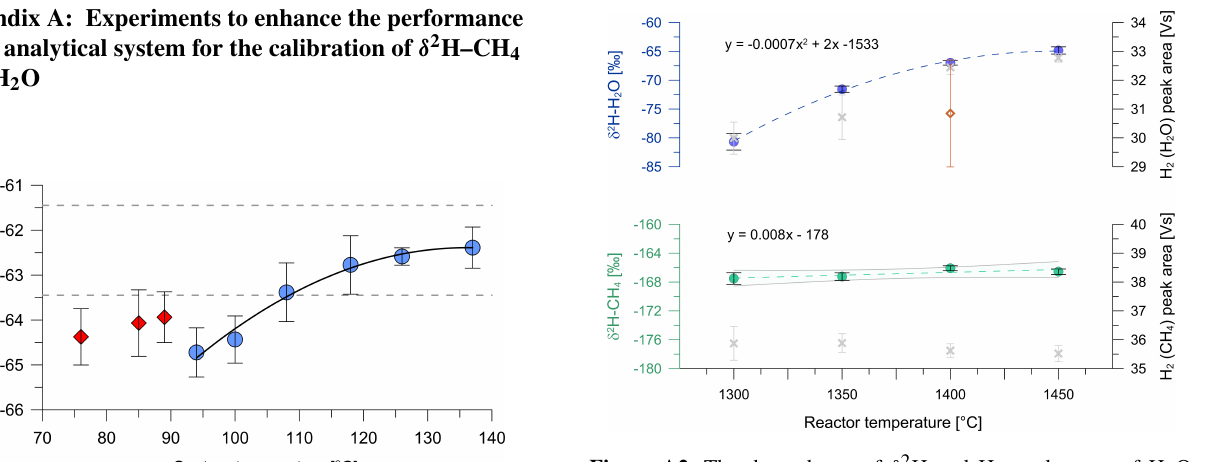
Figure A2. The dependence of δ 2 H and H 2 peak areas of H 2 O and CH 4 injections from reactor temperatures between 1300 and 1450 ◦ C. Top and bottom panels show H 2 O and CH 4 experiments respectively. δ 2 H isotope ratios are shown in blue for H 2 O and green for CH 4 and refer to the left-hand axes. Average H 2 peak areas are indicated by grey crosses and refer to the right-hand axes. All error bars indicate the standard deviation. The red diamond shows the average peak area and the respective standard devia- tion including the outliers (see Appendix text). Y axes ranges are matched between top and bottom panels to enable direct compari- son of the temperature effect for H 2 O and CH 4 . Equations describe the fits in both panels, displayed by dashed lines. Continuous lines in the bottom panel indicate the 95% confidence interval of the lin- ear